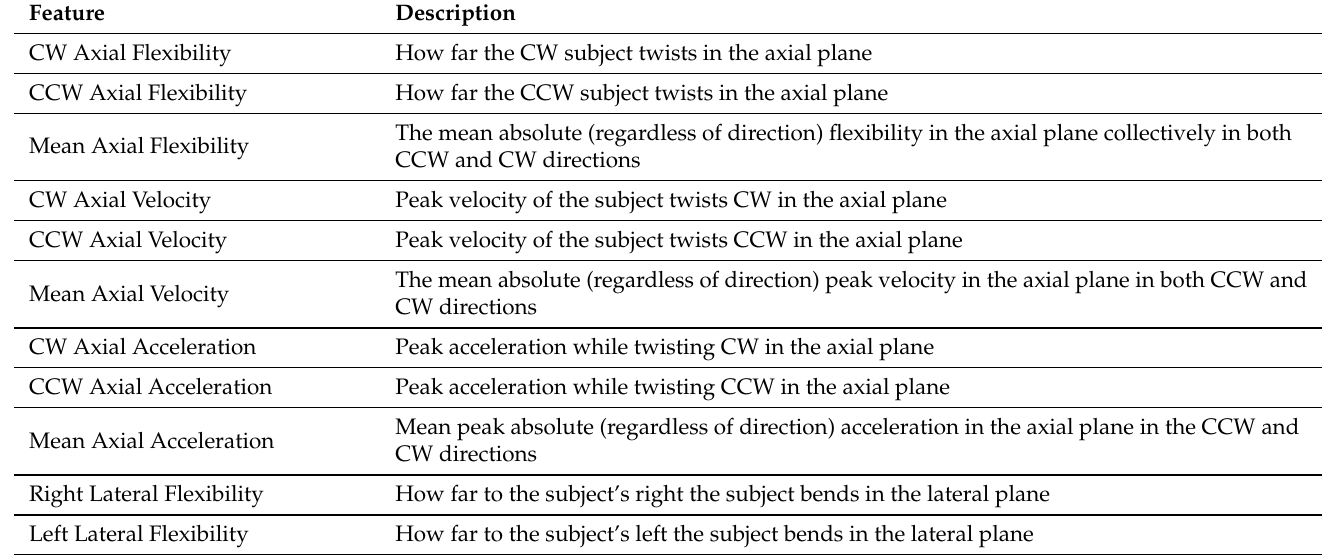
Table A2. Detailed descriptions of all measures extracted from motion